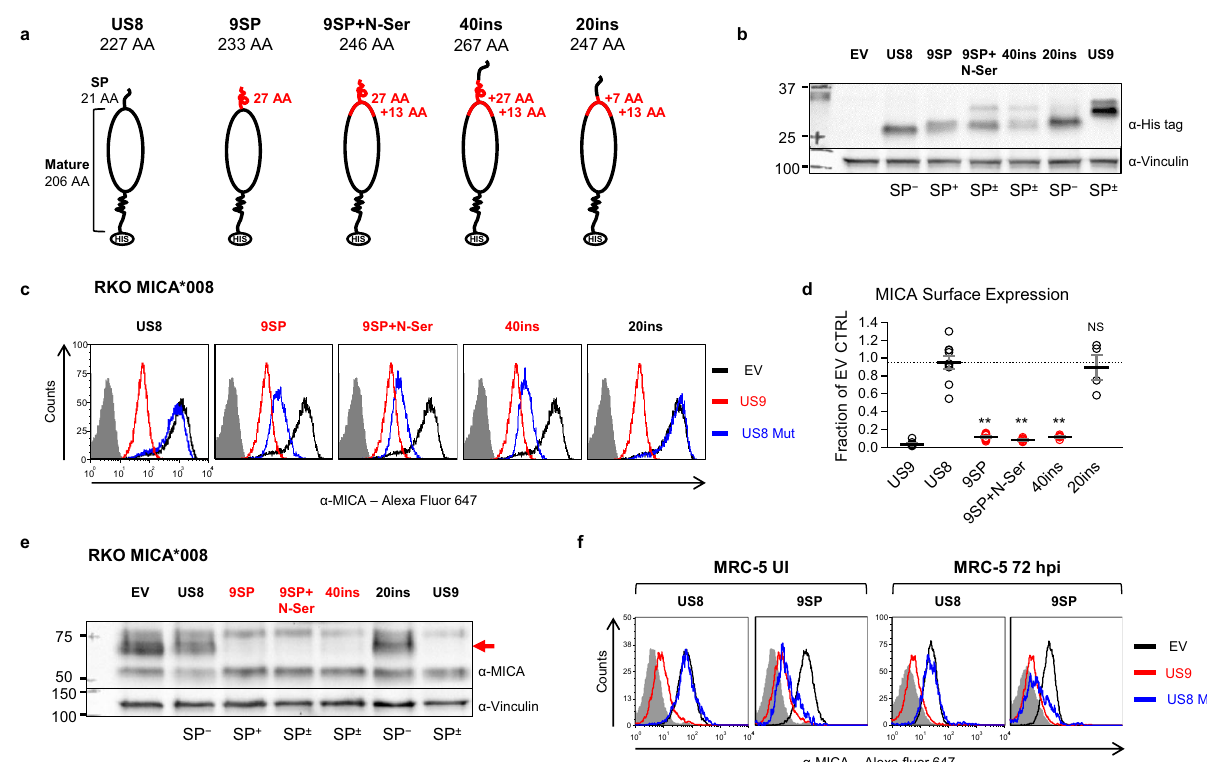
Fig. 4 The US9 SP is suf fi cient for targeting MICA*008 to degradation. a Schematic representation of US8 and the indicated US8 mutants. US9 domains of the indicated length (solid red lines) substituted US8 ’ s endogenous SP or were inserted after it. The total length of each construct without tags is indicated. b Lysates from RKO MICA*008-HA cells transduced with the constructs described in ( a ) were immunoblotted. Anti-His tag was used to visualize protein expression, with anti-vinculin as loading control. Annotation beneath the panel indicates the US9 SP status of the constructs (SP + / − /± ). Representative of three independent experiments. c Flow cytometry of MICA surface expression in cells transduced with an EV (black histograms) US9 (red histograms) or the indicated US8 constructs (blue histograms). Red font highlights gain-of-function constructs. Gray- fi lled histograms represent secondary antibody staining of EV cells. d Quanti fi cation of MICA MFIs shown in ( c ), normalized to the EV control. Data show mean ± SEM for at least four independent repeats per mutant. A one-way ANOVA was performed with a signi fi cant effect at the p < 0.05 level for all conditions [F(4,31) = 68.528, p = 6 × 10 − 15 ]. A post hoc Dunnett ’ s test was used to compare the MFI for 8SP (dashed line) to that of each mutant. ** p < 0.01, NS non-signi fi cant. Red circles highlight gain-of-function. e Lysates obtained from the indicated mutants described in ( a ) were blotted using anti-MICA, anti-His tag, and anti- vinculin as loading control. Red font highlights gain-of-function, and the red arrow indicates post-ER MICA*008. Representative of three independent experiments. f MRC-5 fi broblasts were transduced with an EV (black histograms), WT US9 (red histograms) or the indicated US8 constructs (blue histograms), and then left uninfected (UI; left panels) or infected with Δ US9 HCMV and stained for MICA expression at 72 h post infection (hpi; right panels), as part of the same experiment shown in Fig. 3e. Gray- fi lled histograms represent isotype-control staining of EV cells. Red font highlights gain-of- function. Representative of three independent experiments. See also Figs. S3 – 4 and the Source data fi le for experimental data and full